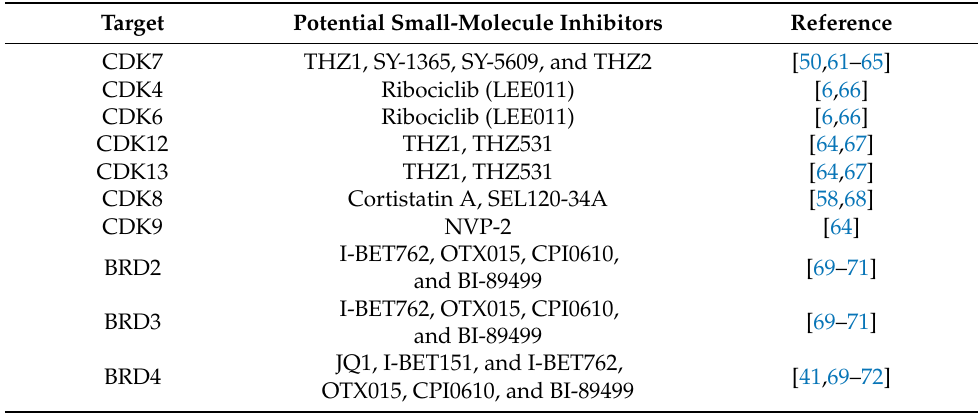
Table 1. Targets and their potential inhibitors of disrupting SE